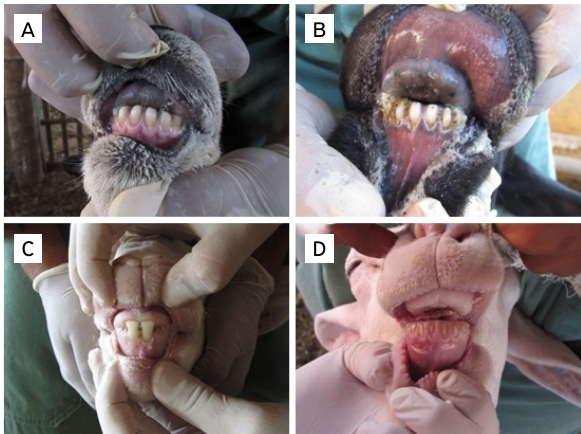
Figure 2. Erosion of incisor teeth resulting from the ingestion of despectinated wet citrus pulp: (A) polishing the incisor teeth; (B) yellowish appearance of the teeth, erosion of the enamel and retraction of the gingiva; (C) young animal, in which the tweezers were changed, with complete corrosion of the milk teeth; (D) complete corrosion of the incisor